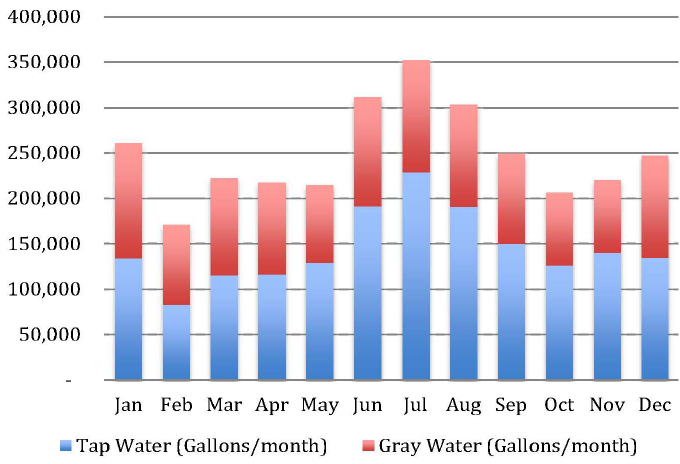
Figure 11. Shenzhen IBR monthly water consumption